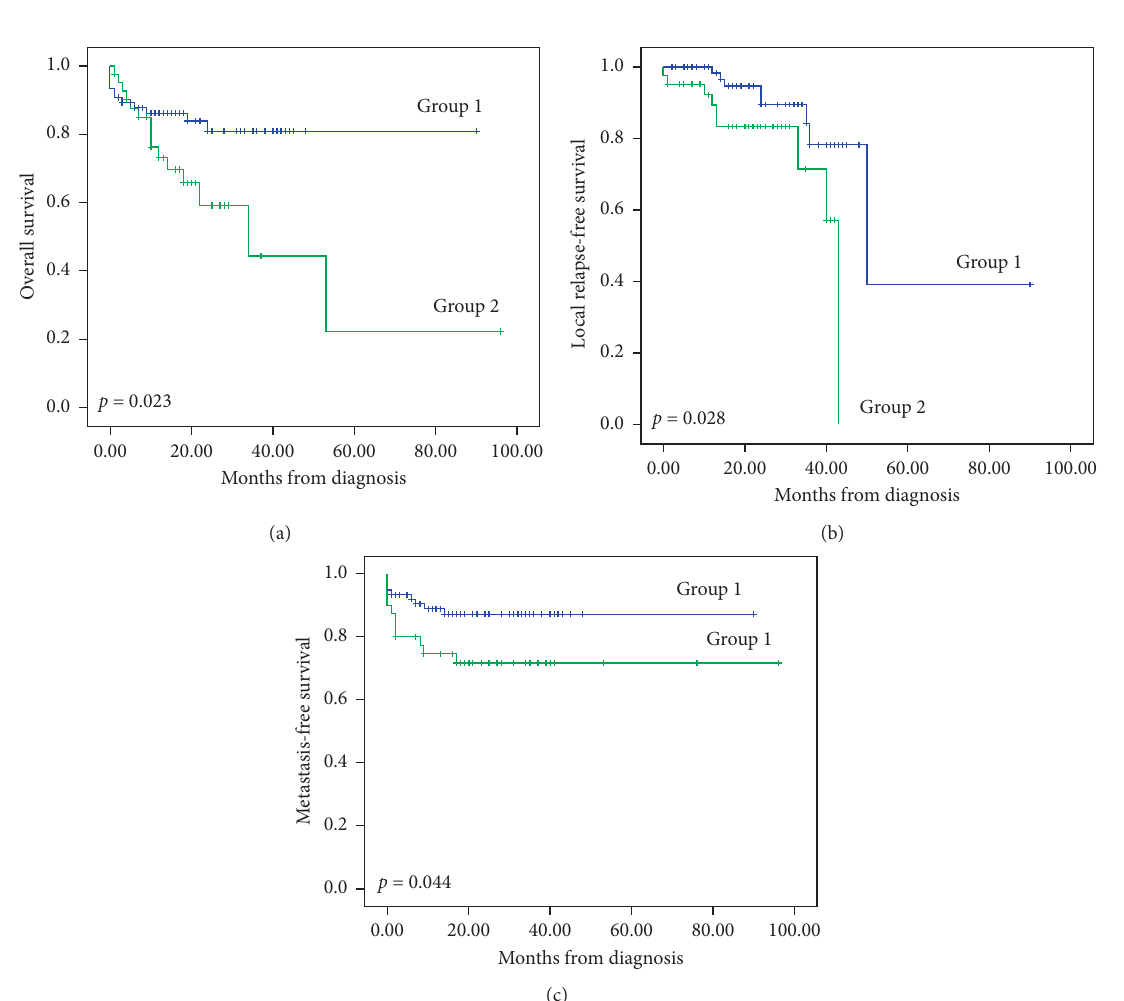
Figure 3: Patient survival of studied groups (overall survival, relapse-free survival, and metastasis-free survival).